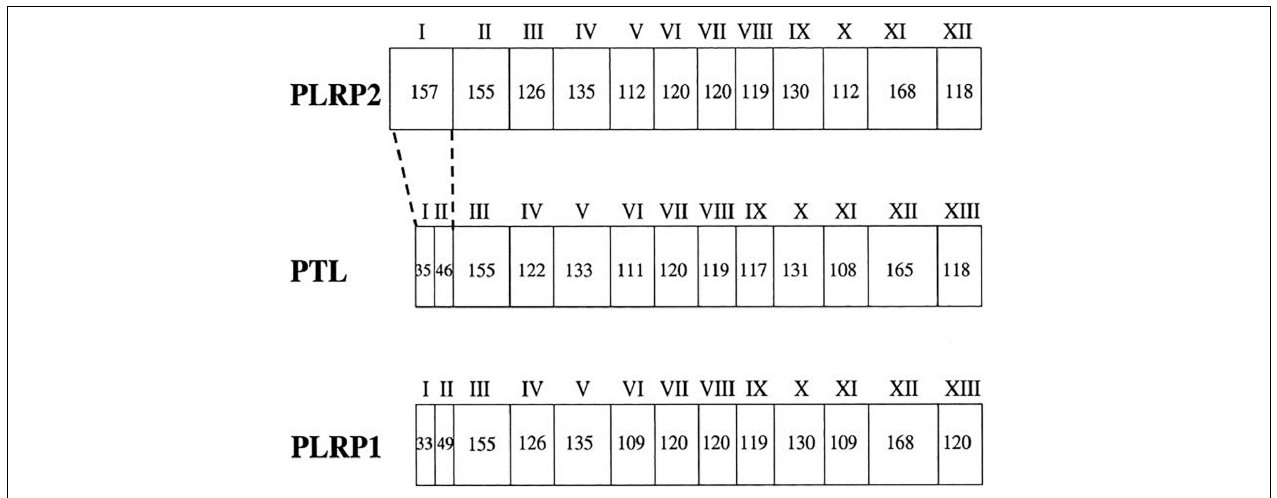
FIGURE 1 | The gene structure for PTL (PNLIP), PLRP1 (PNLIPRP1), and PLRP2 (PNLIPRP2). The exons are numbered with roman numerals. The number of nucleotides in each exon is given in each box. The biggest difference in exons is that PTL (PNLIP) and PLRP1 (PNLIPRP1) both have 13 exons, whereas PLRP2 (PNLIPRP2) only has 12 exons, but it contains a larger exon I (157 bp). PTL (PNLIP), pancreatic triglyceride lipase; PLRP1 (PNLIPRP1), pancreatic lipase-related protein 1; PLRP2 (PNLIPRP2), pancreatic lipase-related protein 2.